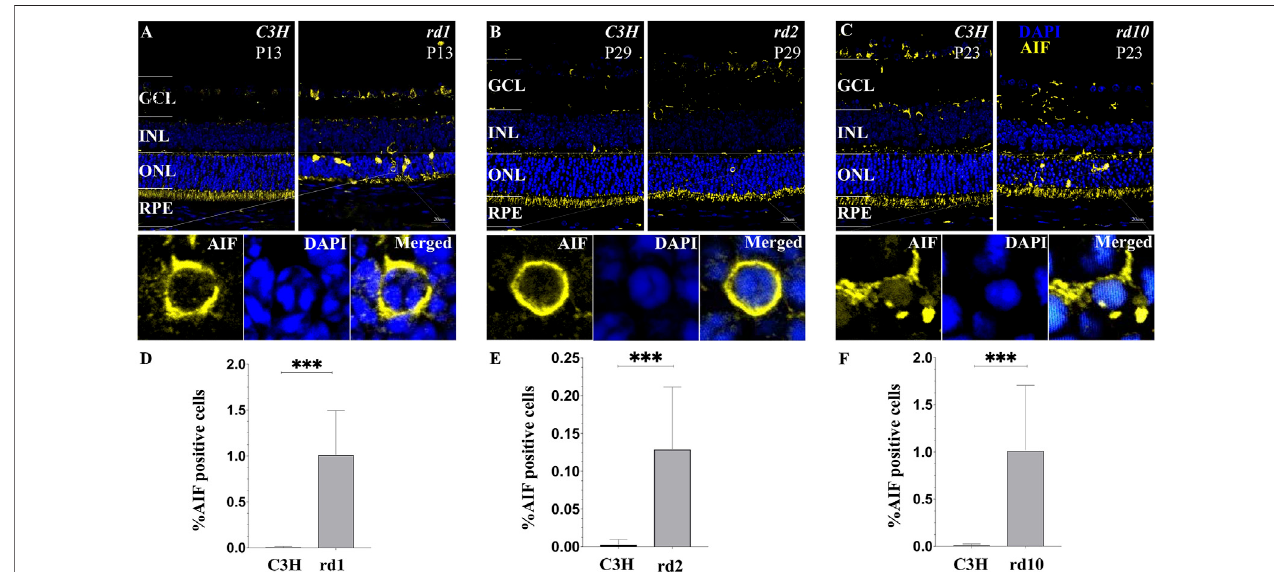
FIGURE 8 | Translocation of AIF in various models of RD photoreceptors. (A – C) Confocal microscopy of RD retinal sections stained with AIF (yellow fl uorescence) and thenucleardyeDAPI(blue). CellsthatdemonstrateaclearAIFstainingofthenucleuswereregardedaspositiveforAIFtranslocation. (D – F) NotethatC3Hwild-type control lack any detectable AIF redistribution to the nucleus. The values shown originate from three RD mutants from at least three different specimens. Quanti fi cation in bargraphsdisplaysthepercentageofAIFpositivecellsintheouternuclearlayer(ONL).Signi fi cancelevelsindicatedbyasterisks:* (cid:1) p < 0.05,** (cid:1) p < 0.01,*** (cid:1) p <